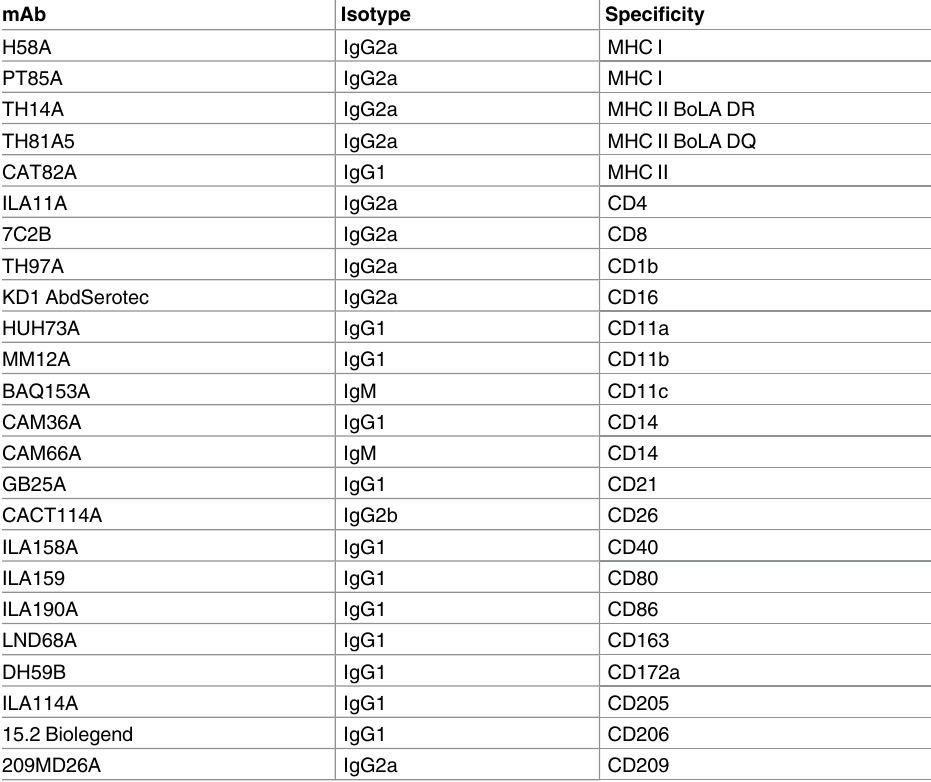
Table 1. Monoclonal antibodies used in present study. mAb Isotype